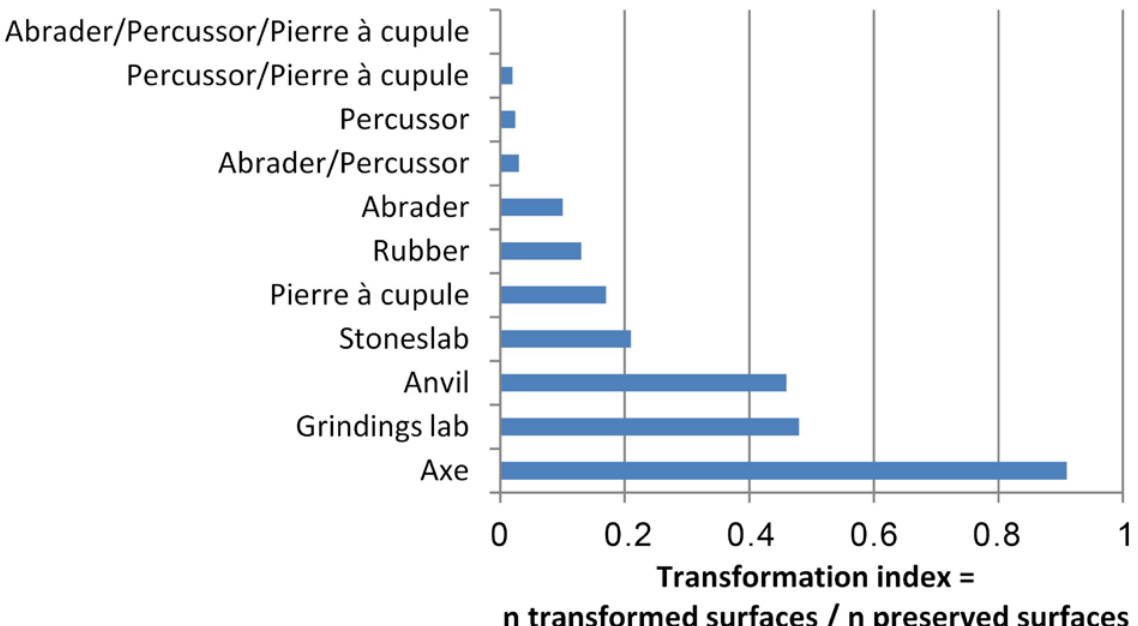
Figure 6. Transformation index of the most abundant artefact types recorded in the wet soil area of Bruszczewo, exposed in ascending